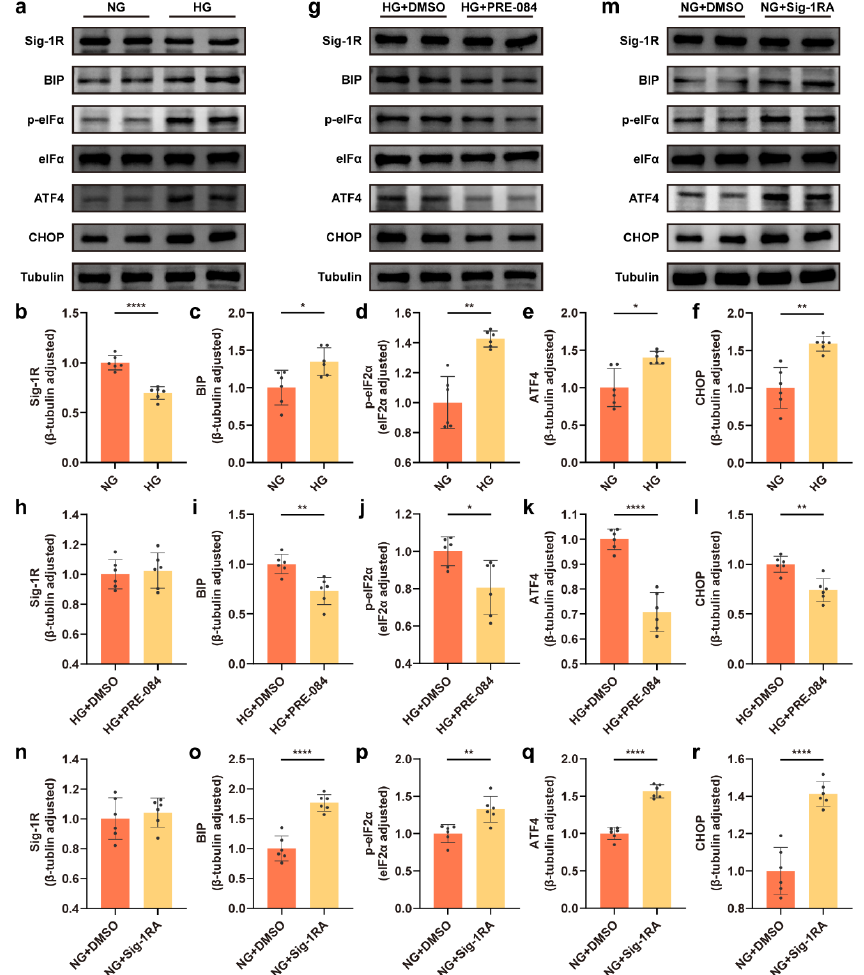
Figure 1. Sig-1R regulated HG-induced ERS in astrocytes. ( a – f ) Representative Western blot and quantitative analyses for Sig-1R and the ERS-related protein (BIP, p-eIF2 α , eIF2 α , ATF4, and CHOP) expression in the NG and HG groups ( n = 6). ( g – l ) Representative Western blot images for the Sig-1R and ERS-related protein expression and corresponding quantitation in the HG + DMSO and HG + PRE-084 groups ( n = 6). ( m – r ) Representative Western blot images and relevant quantitation of the Sig-1R and ERS-related protein expression in the NG + DMSO and NG + Sig-1RA groups ( n = 6). The data were presented as mean ± SEM and analyzed using the Student’s t test or Welch’s t test. * p < 0.05; ** p < 0.01; **** p < 0.0001. Sig-1R, sigma-1 receptor; HG, high glucose; ERS, endoplasmic reticulum stress; BIP, binding immunoglobulin protein; eIF2 α , eukaryotic translation initiation factor-2 α ; ATF4, activating transcription factor 4; CHOP, C/EBP homologous protein; NG, normal glucose; Sig-1RA, Sig-1R antagonist.